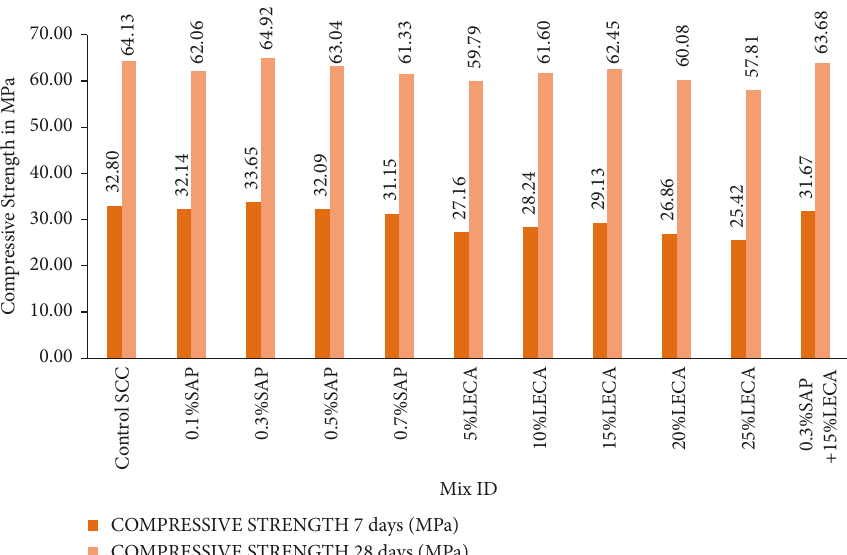
Figure 10: Compressive strength of all SCC mixes.